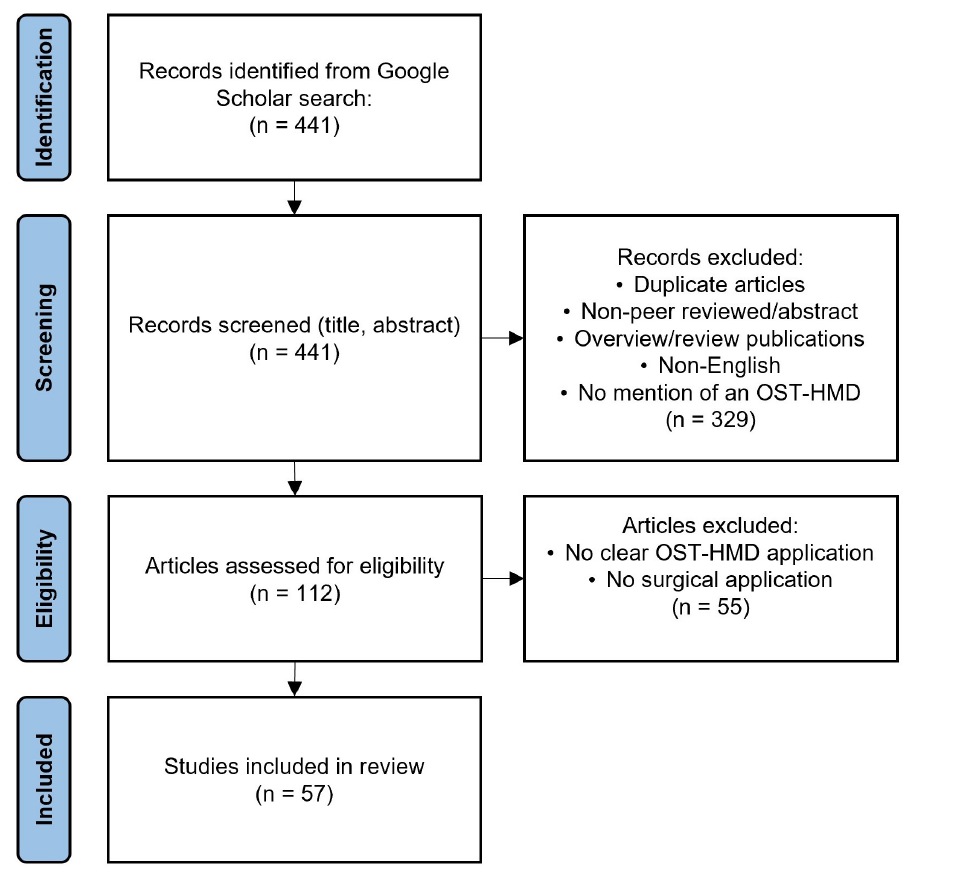
Figure 5. Search strategy of our systematic